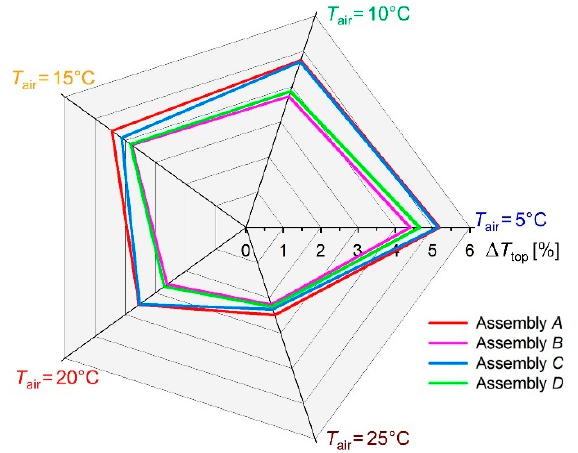
Figure 10. Percentage difference between experimental and simulated temperature of top assembly surface Δ T top obtained for 5 environmental conditions. As can be seen from the radar chart, the greatest differences Δ T top range from 4.40% (Assembly B ) to 5.18% (Assembly A ) and were observed for an ambient temperature T air = 5 °C; the smallest differences Δ T top range from 2.19% (Assembly B ) to 2.48% (Assembly A ) were obtained for an ambient temperature T air = 25 °C. In general, it can be concluded that the assembly models are less thermally insulating than their real counterparts. The une- ven distribution of temperature on the top surface of the tested assemblies, visible on the thermograms (Figure 7), may indicate that the distribution of matter in the individual lay- ers is non-uniform and that these layers do not adhere to each other over the entire tested surface (which causes local air gaps). These two factors contribute to the unequal heat transfer through the assemblies. 4. Discussion Apart from the temperature of top assembly surface T top , the results of the heat trans- fer simulation allowed for the analysis of other parameters of the modeled phenomenon. On the basis of the temperature distribution over the thickness of each assembly (Figure 9), the heat losses in each layer of the assembly were calculated and presented in the form of pie charts in Figure 11.